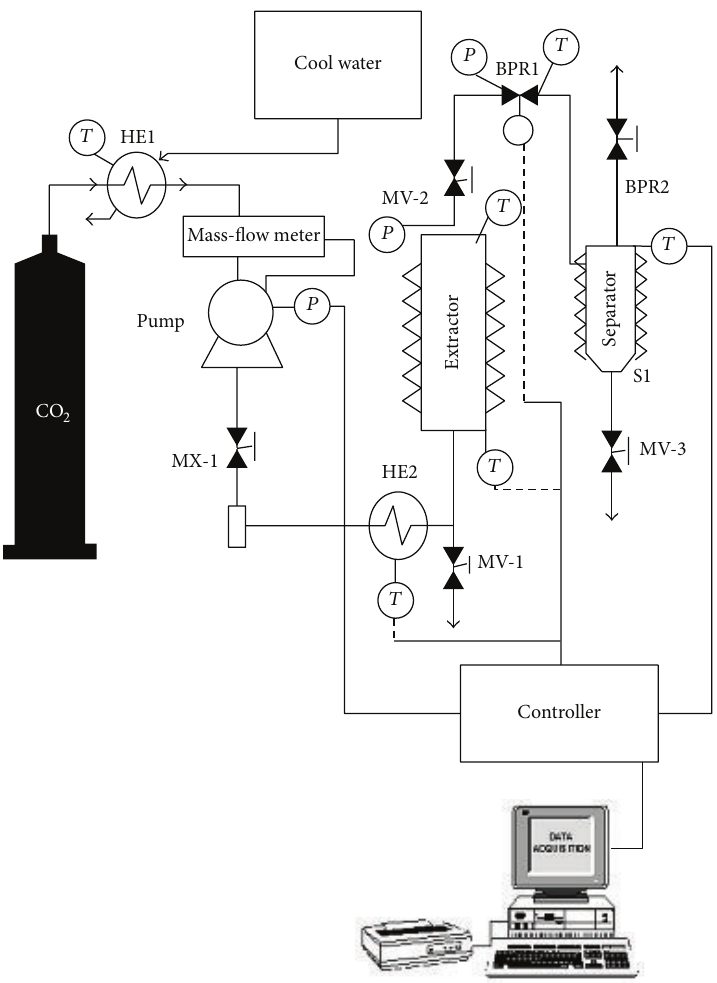
Figure 1: Schematic diagram of the